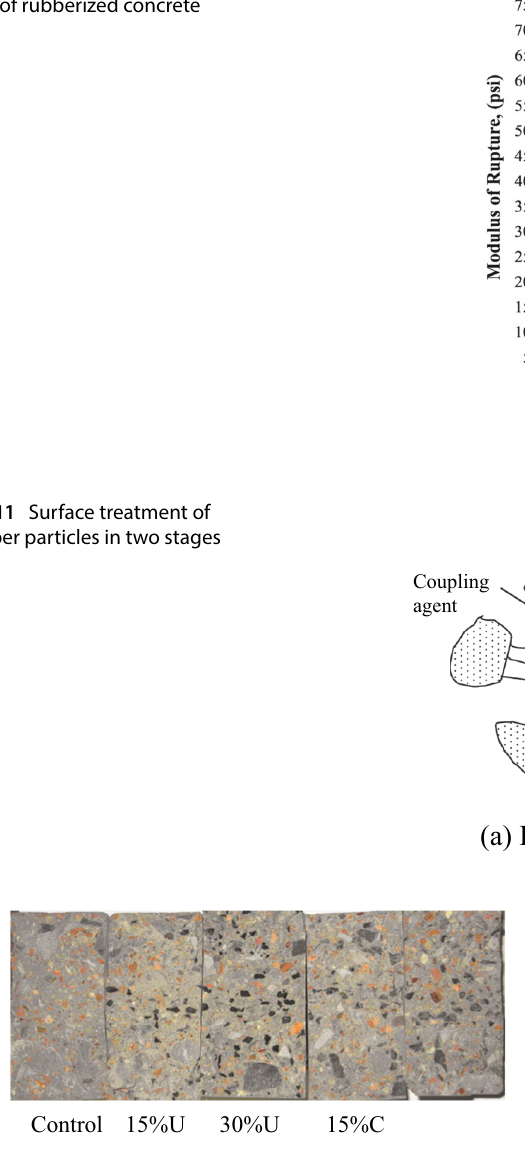
Fig. 12 Split tensile test of specimens after 28